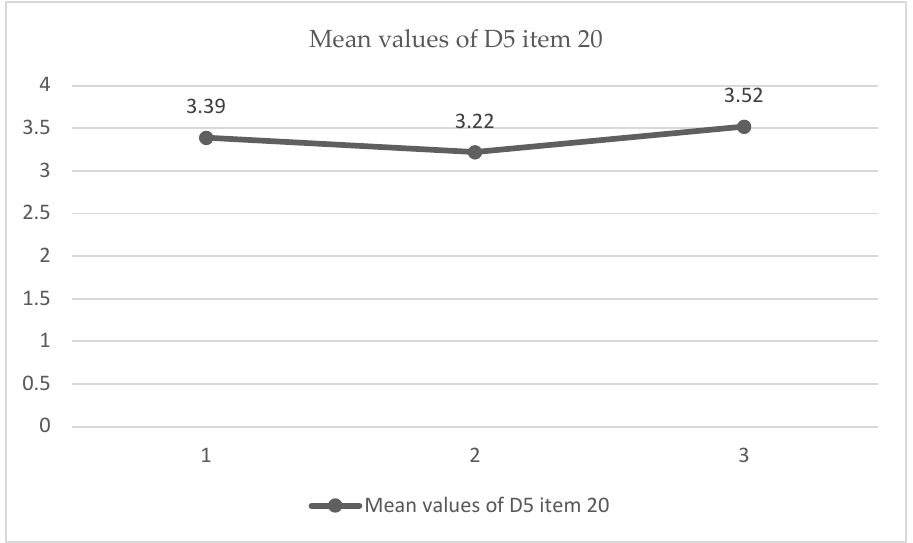
Figure 3. Diagram of means. Comparison of item 20 between all 3 observations ( p < 0.05) ( n = 23).